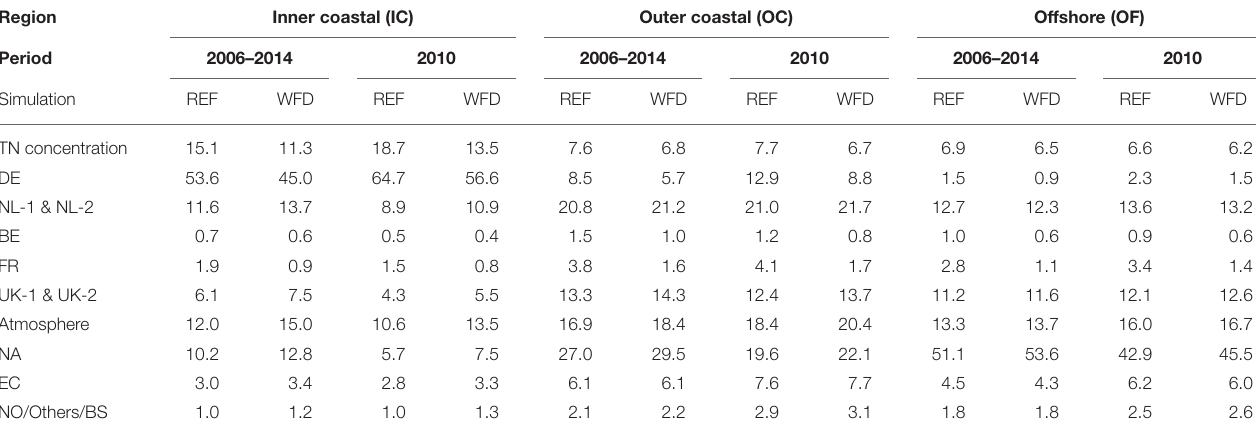
Region Inner coastal (IC) Outer coastal (OC) Offshore (OF)